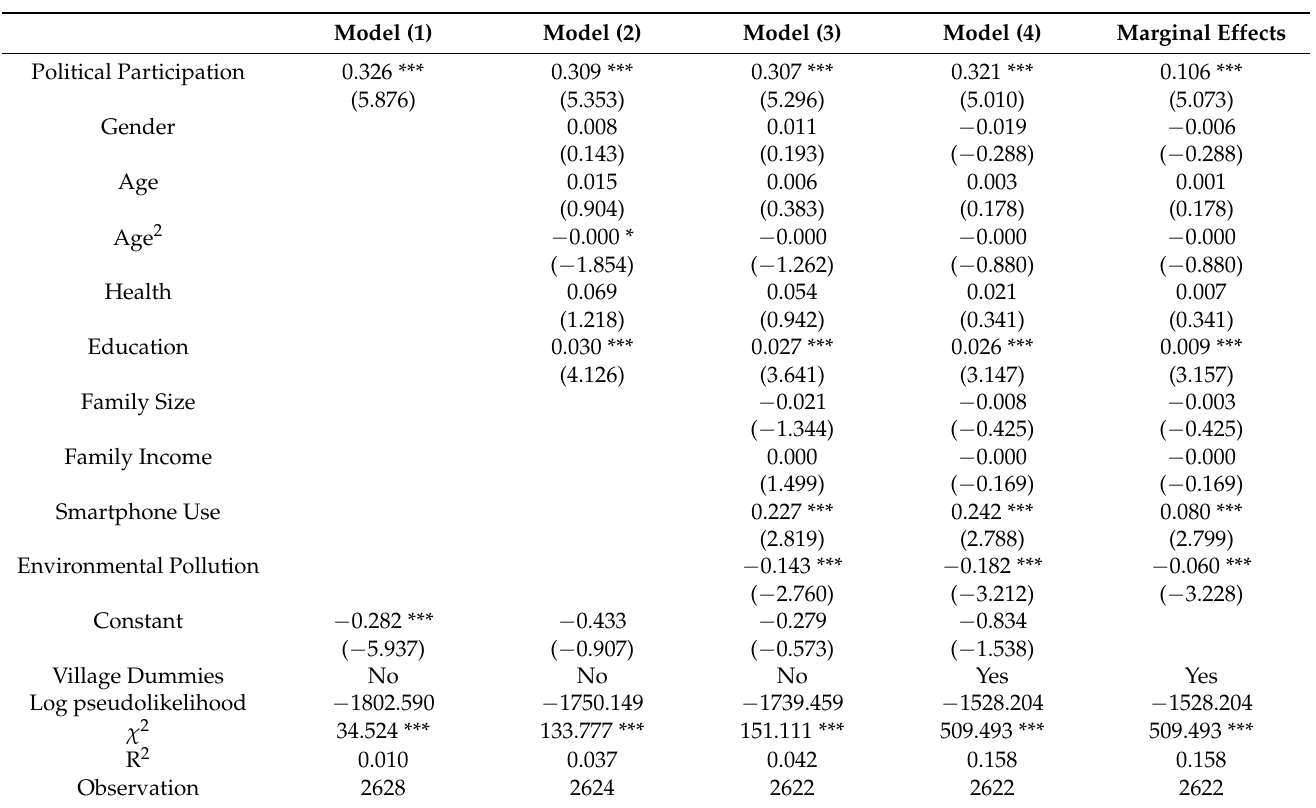
Table 2. Main regression results.